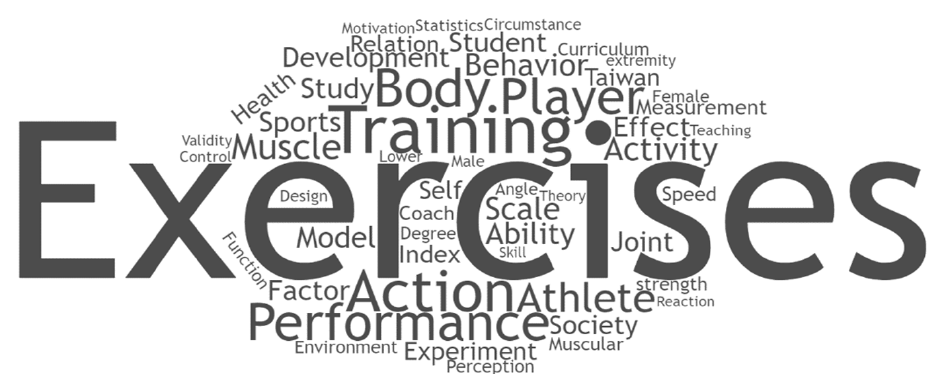
Figure 2. Word cloud of word frequency in China.